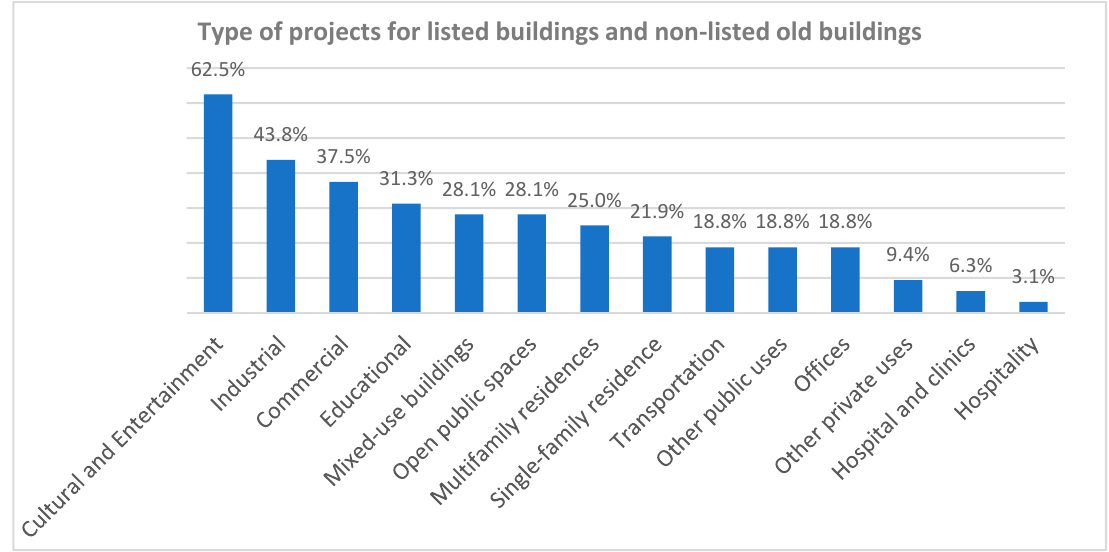
Figure 10. Types of projects for listed buildings and non-listed old buildings worked in the last 12 months.